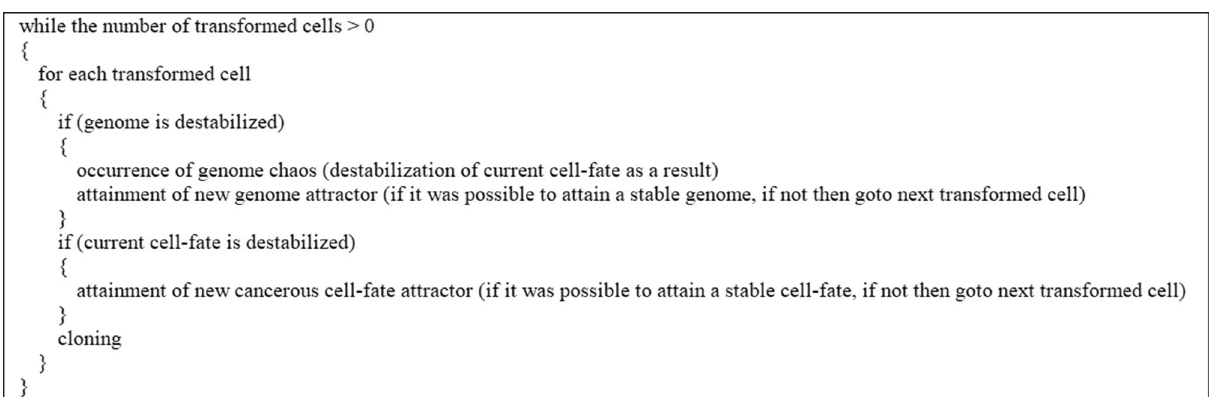
Figure 10. Schema of cancer